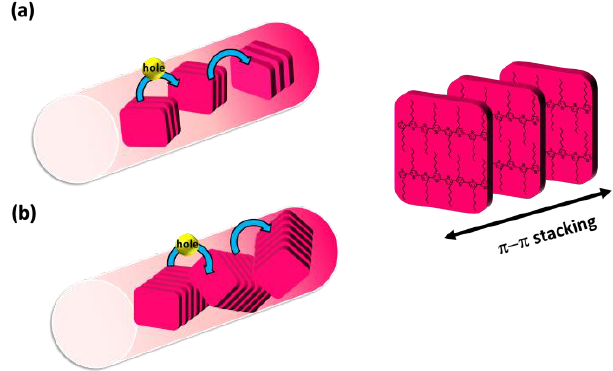
Figure 10. Schematic illustrations of the chain packing and crystalline grain orientation in P3HT electrospun nanofibers prepared from ( a ) CF or CB and ( b ) TCB systems, where the red bricks demonstrate the 2D planes from the thiophene rings.